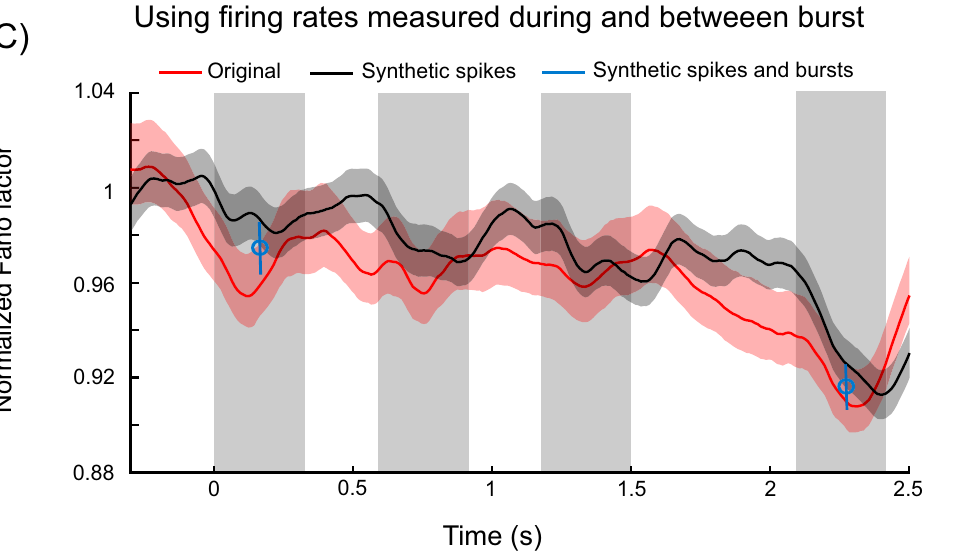
Figure 6. Variability of synthetic spike trains generated based on neurophysiological gamma burst times in Task 1. Spiking rates within the bursts varied from 10 to 1000 sp/s (black to light gray). ( A ) Plotted are the mean (averaged across all the recording sites) FFs normalized divisively by the pre-stimulus average, for a range of simulated spiking rates without ( A ) and with ( B ) an additional synthetic background activity at the level of 1 sp/s. Red line corresponds to the original normalized spike FF for the recorded spiking. ( C ) The FF for original data (red) and synthetic data (black). The synthetic data was created by using the recorded burst times and populating each trial with spikes based on firing rates measured inside and outside bursts per neuron (“Materials and methods” section). Blue marks: FFs in two time windows (normalized by the pre-stim time window; both significantly lower than pre-stimulus window using Wilcoxon rank test, p = 0.007 for sample and p < e−30 for test time window) where both burst counts and the corresponding spiking was synthesized from data. First, burst counts were produced based on the distribution of burst counts in the selected time window for each electrode. The synthetic spike trains were then produced as above (see also “Materials and methods”